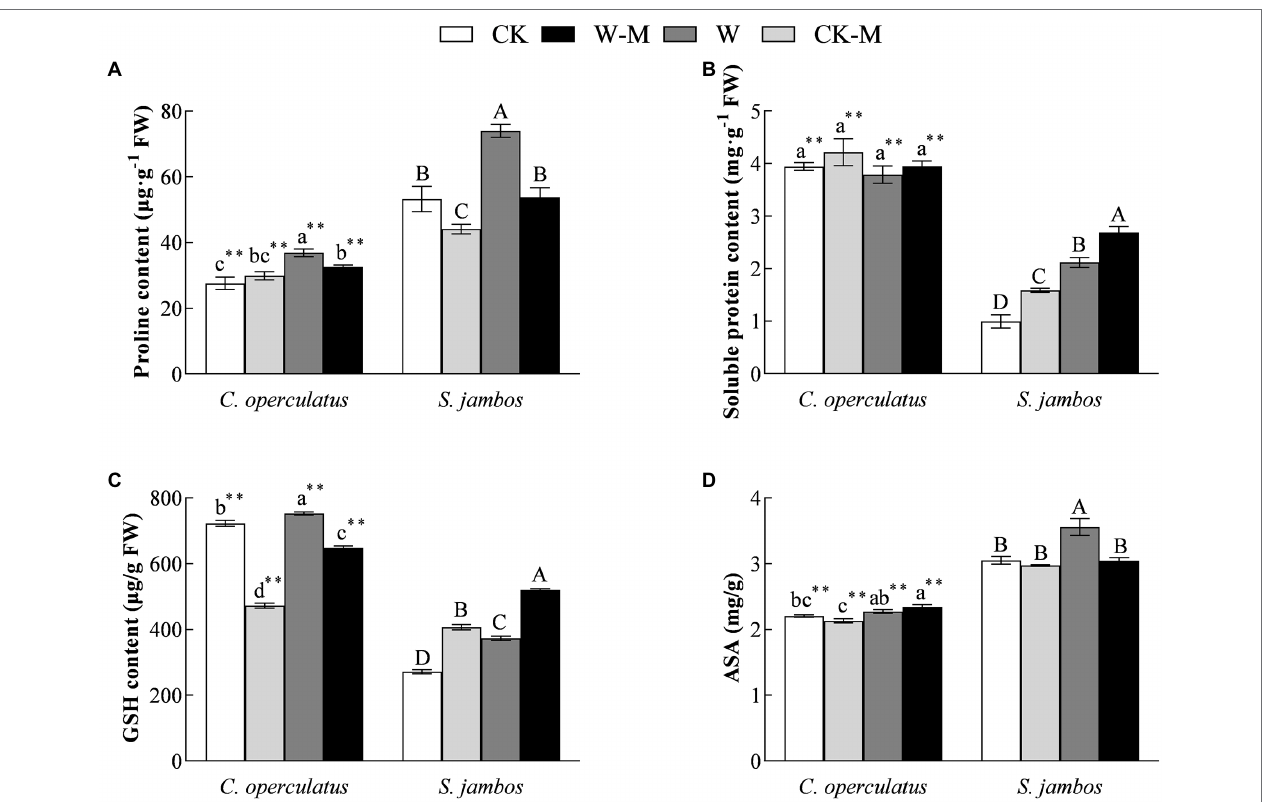
FIGURE 4 | The variations of proline (A) , soluble protein content (B) , GSH content (C) and ASA (D) in C. operculatus and S. jambos among different treatments. Values are means ± SE ( n = 6). Different little and capital letters indicate significant differences among different treatments within the same species according to ANOVA’s test ( p < 0.05). CK, pure planting pattern under well-watered condition; CK-M, mixed planting pattern under well-watered condition; W, pure planting pattern under waterlogging condition, W-M; mixed planting pattern under waterlogging condition. The sign ** concerns the significance difference between the two species under the same treatment. ** p <